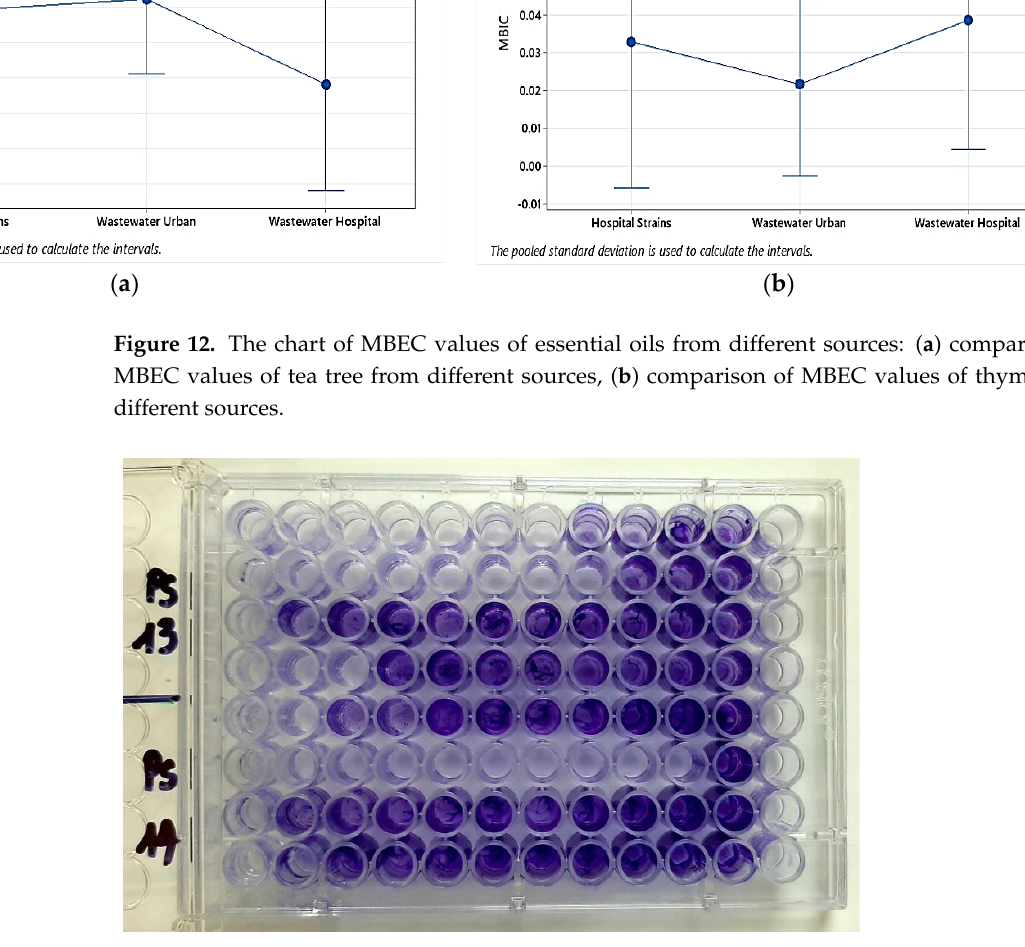
Figure 13. Aspect of 96 well plates after CV staining in cases of 2 P. aeruginosa strains treated with EOs (last column (12) — sterility control, the row before (11) — growth control).